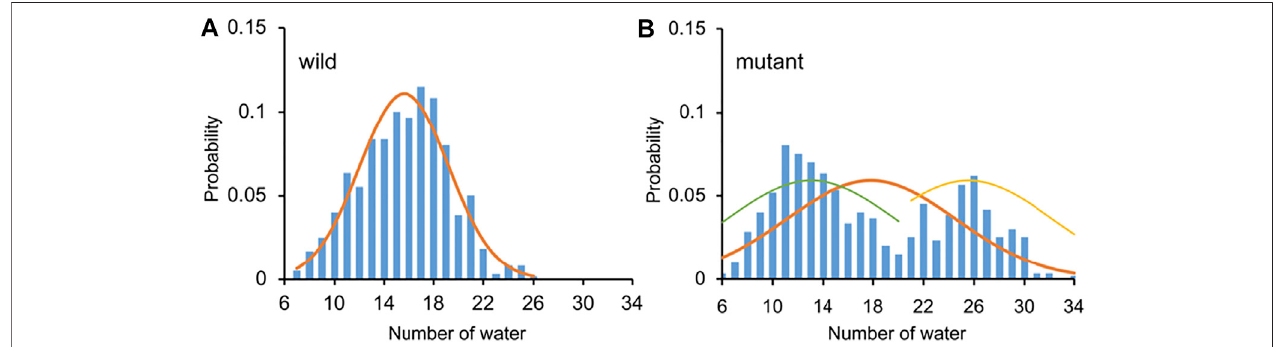
FIGURE4| Thenumber ofwatermolecules and thecorrespondingprobabilityin thepore oftheWT (A) and the L210F mutant (B) channels. FromresidueF171 to E178 along the central axis of the pore, the number of water molecules (oxygen atoms were measured) within a cylinder of 5-Å radius was calculated using VMD for the last 200 ns of all three trajectories for each protein